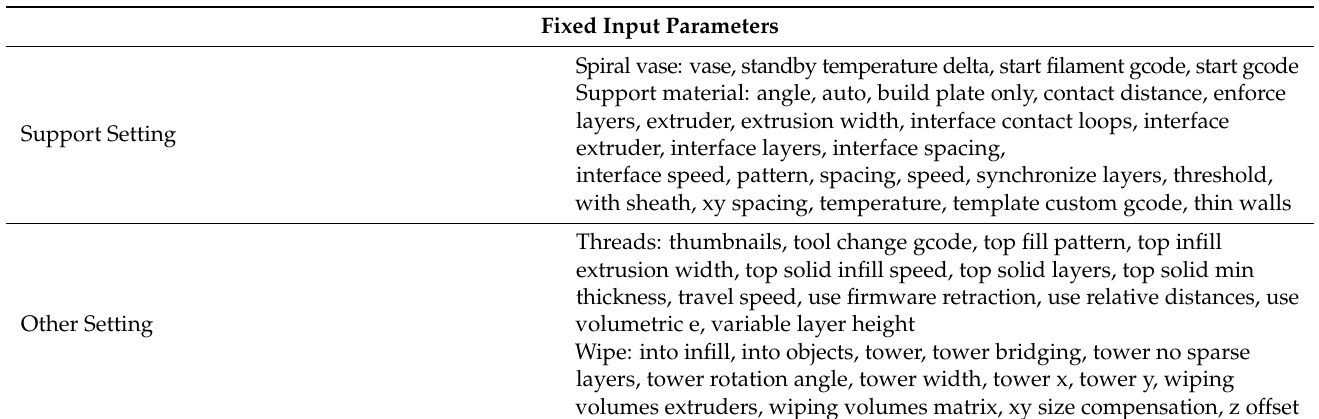
Table 1. Cont. Fixed Input